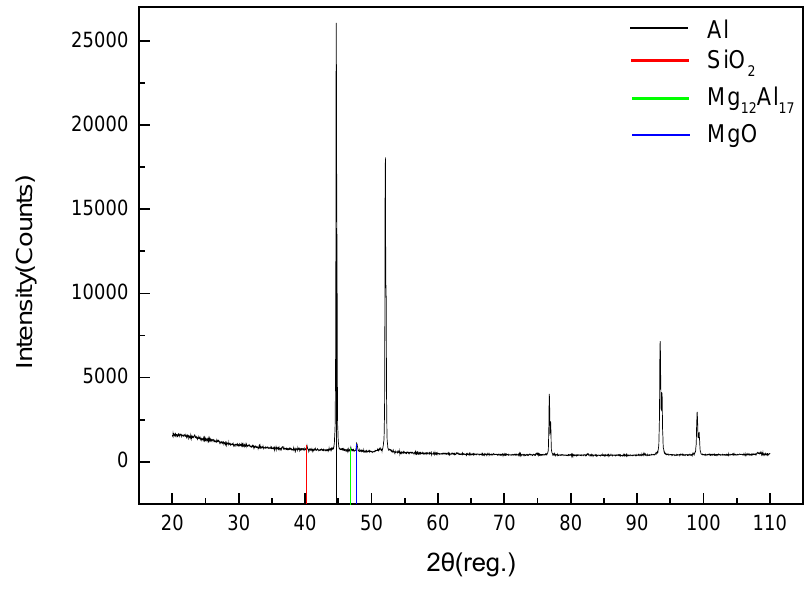
Figure 17. X-ray diffraction (XRD) patterns of specimens with flame straightening.